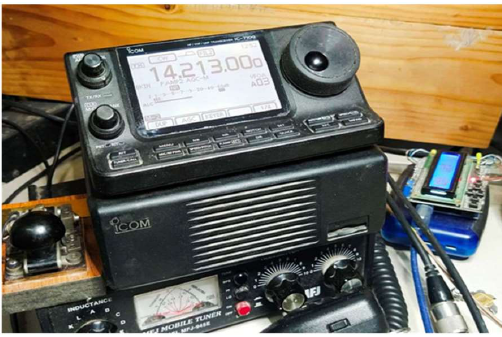
Fig. 15. Shows Icom transceiver model IC-7100 with tuner box from MFJ model MFJ 945E.